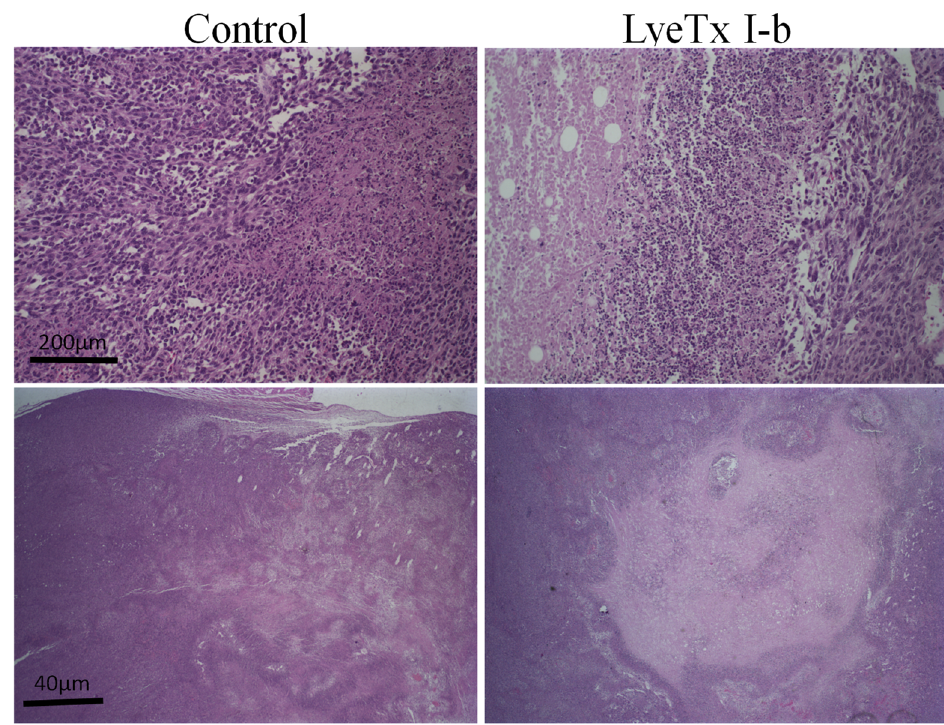
Figure 5. Assessment of morphological aspects of 4T1 murine primary tumor. Representative pictures of hematoxylin and eosin staining using low magnification showed a large necrosis area in the treated group compared to the untreated group, n = 6. In the control group, were observed inflammatory cell infiltrate, necrotic area, and viable tumor cells, whereas in the treated group the extensive necrotic area was characterized by the presence of nucleus chromatin condensation accompanied by fragmented nuclei into various segments (karyorrhexis). Objectives: 4× and 20×. Scale bars: 200 µm and 40 µm.